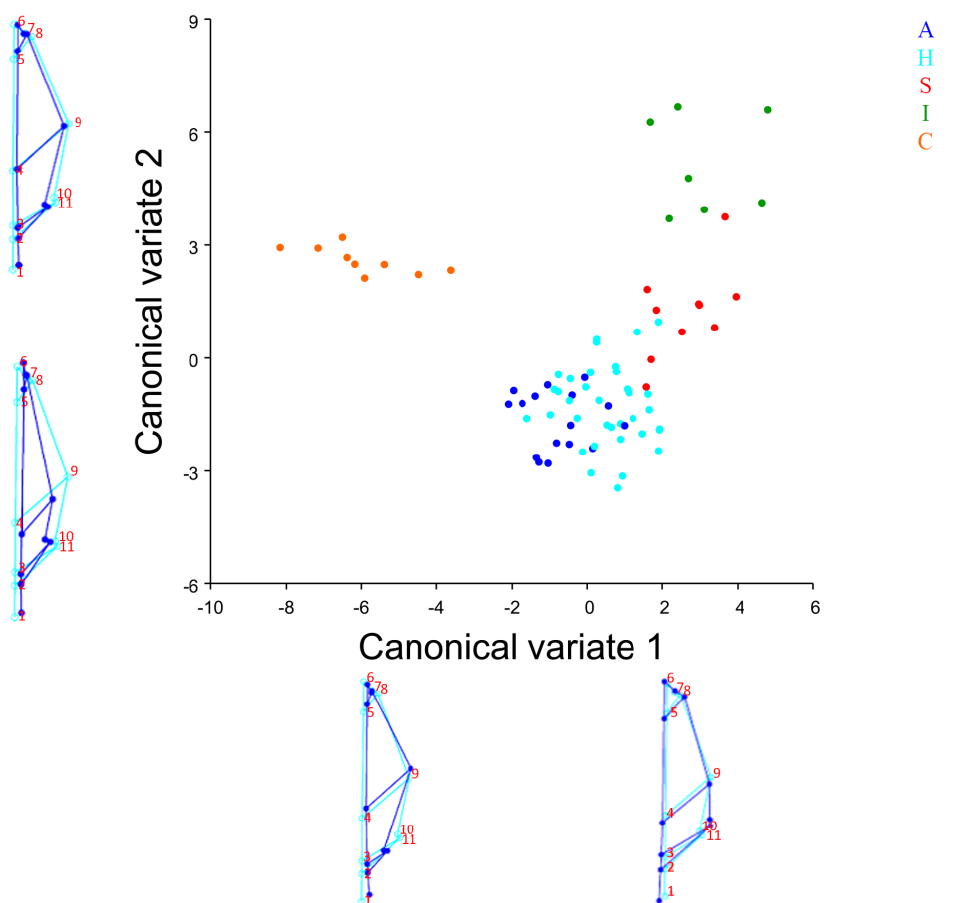
Figure 4. Canonical analysis of the four species and hybrids in the Akfadou forest [ Q. afares (A), Q. suber (S), Q. ilex (I), Q. canariensis (C) and the hybrids (H)], and representation of leaf differences along the two canonical axes (CV1 = 47.08%; CV2 = 35.88%). The Cross-validation of DA has revealed an overlap of hybrids with Q. afares , and to a lesser extent with Q. suber (T2 values significant, p < 0.0001). The overlaps with Q. canariensis and Q. ilex are non-significant (Figure